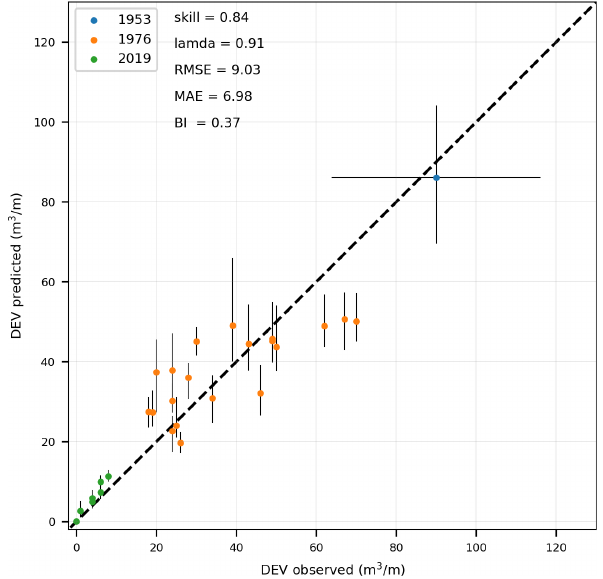
Figure 10. Scatterplot between the observed ( x axis) and ANN- predicted ( y axis) DEV for three historic storms with a variable number of transects per storm. The dots indicate the average pre- dictions of the ANN, while the vertical lines show the min and max values as given by the ensemble of the ANN output. For the storm of 1953 the horizontal line gives the range of the values reported.